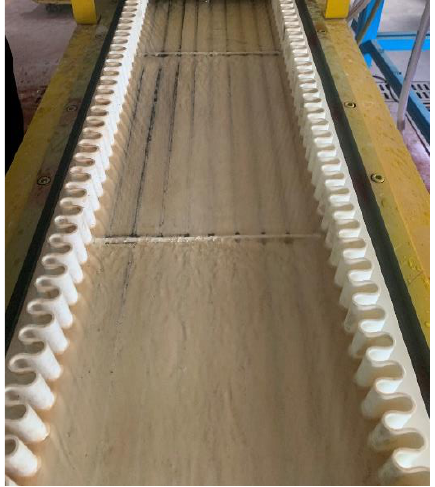
Figure 9. Cloud diagram of slurry vector distribution and volume fraction on belt surface.